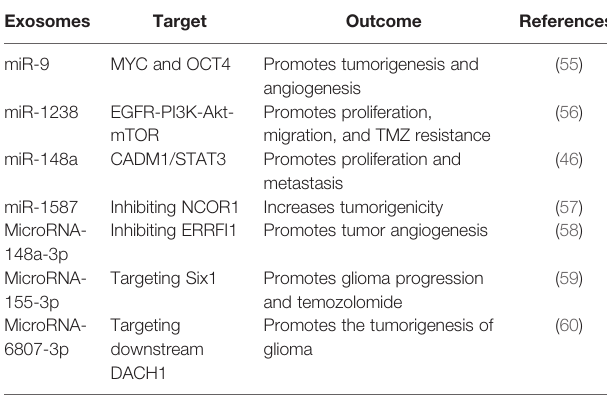
TABLE 1 | Exosomes that are involved in